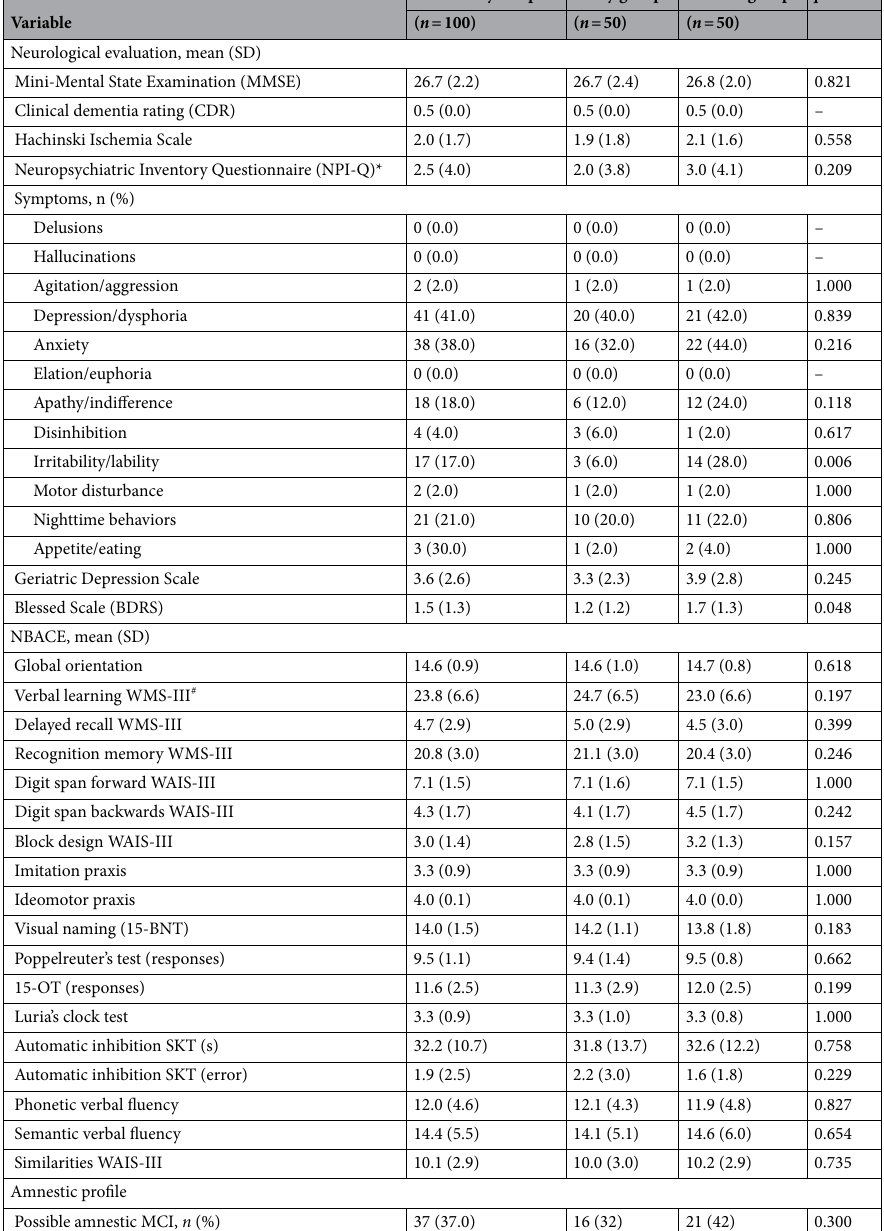
Table 3. Baseline neuropsychological characteristics of the study participants. SD standard deviation, WMS-III Wechsler Memory Scale, Third Edition, WAIS-III Wechsler Adult Intelligence Scale, Third